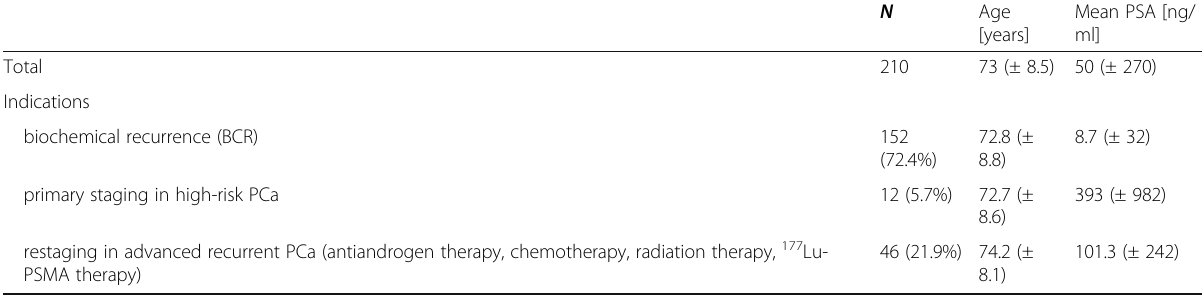
Table 1 Patient ’ s characteristics and indications for [ 99m Tc]Tc-PSMA-I&S-SPECT/CT